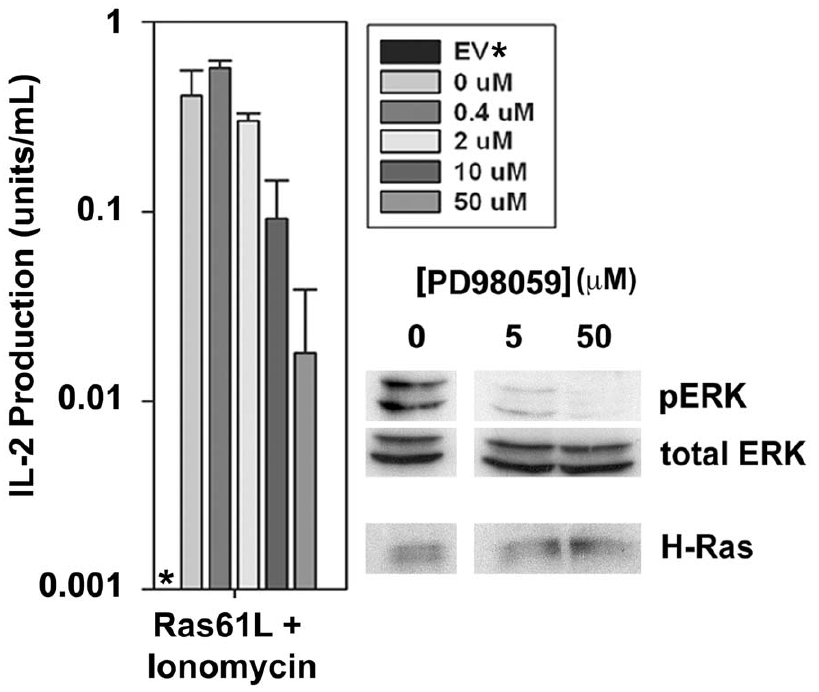
Figure 6. Ionomycin induced IL-2 production in Ra61L transduced cells is dependent on MEK signaling. CARTg Th1 T cells were transduced with active Ras and preincubated for 30 minutes with varying amounts of the MEK-1 inhibitor PD98059. Cells were then either stimulated with ionomycin (50 mg/mL) for 30 minutes and analyzed for ERK phosphorylation by Western blot, or stimulated with ionomycin overnight in triplicate and supernatants were collected and analyzed for IL-2 production by ELISA. Star (*) indicates no detectable IL-2 produced by empty vector transduced cells stimulated with ionomycin. Error bars where shown indicate standard deviations of the mean between triplicate samples from the same experiment.